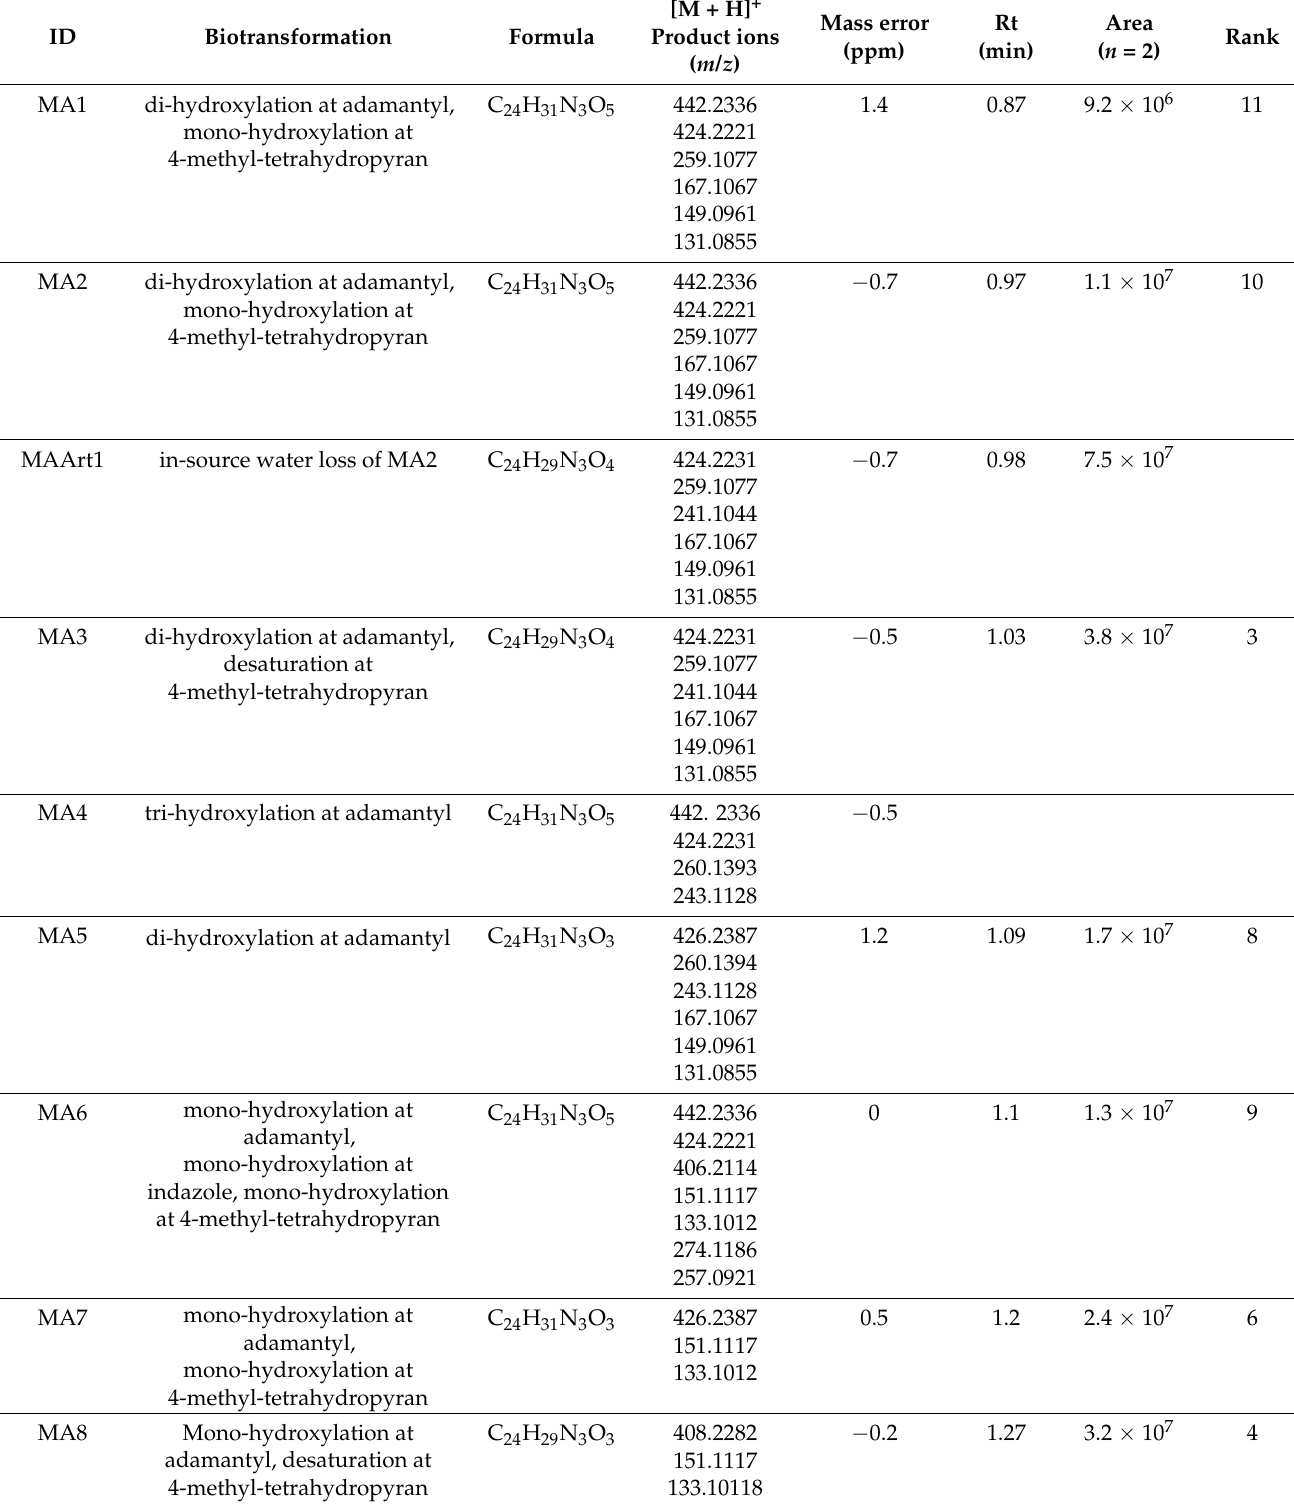
Table 3. Summary of all detected metabolites, and observed artefacts thereof, of ADAMANTY-THPINACA (listed in the order of the observed retention times). Shown are the suggested biotransformations, chemical formulas, calculated [M + H] of the parent ions and the corresponding product ions, as well as retention times, area after 2 h of incubation, and